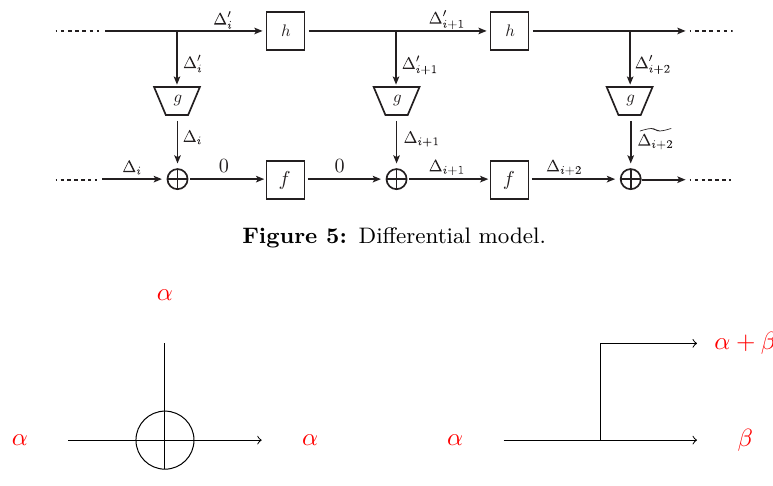
Figure 6: Left: Propagation of linear masks through XOR . Right: Propagation of linear masks through a branching